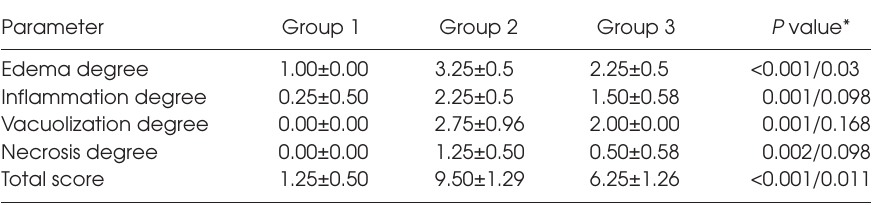
Table 1. Histopathological change of pancreatic tissues in the mice model with acute pancreatitis induced by cerulein.